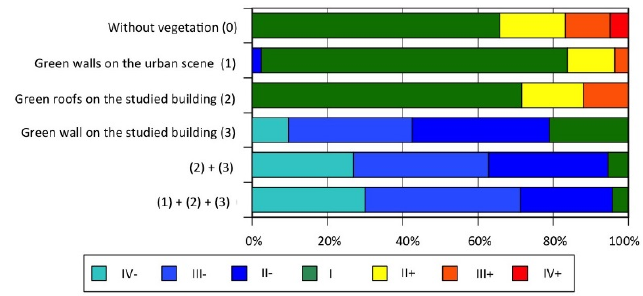
Figure 9. Distribution of the occurrences among thermal comfort categories on the third floor during the day.